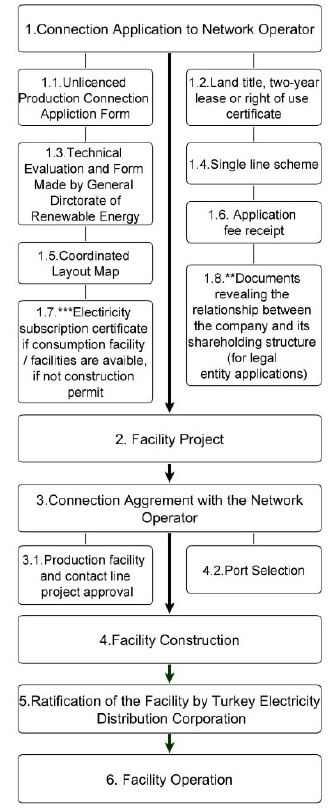
Figure 5. Application Steps for The Unlicensed Electricity Generation from Solar